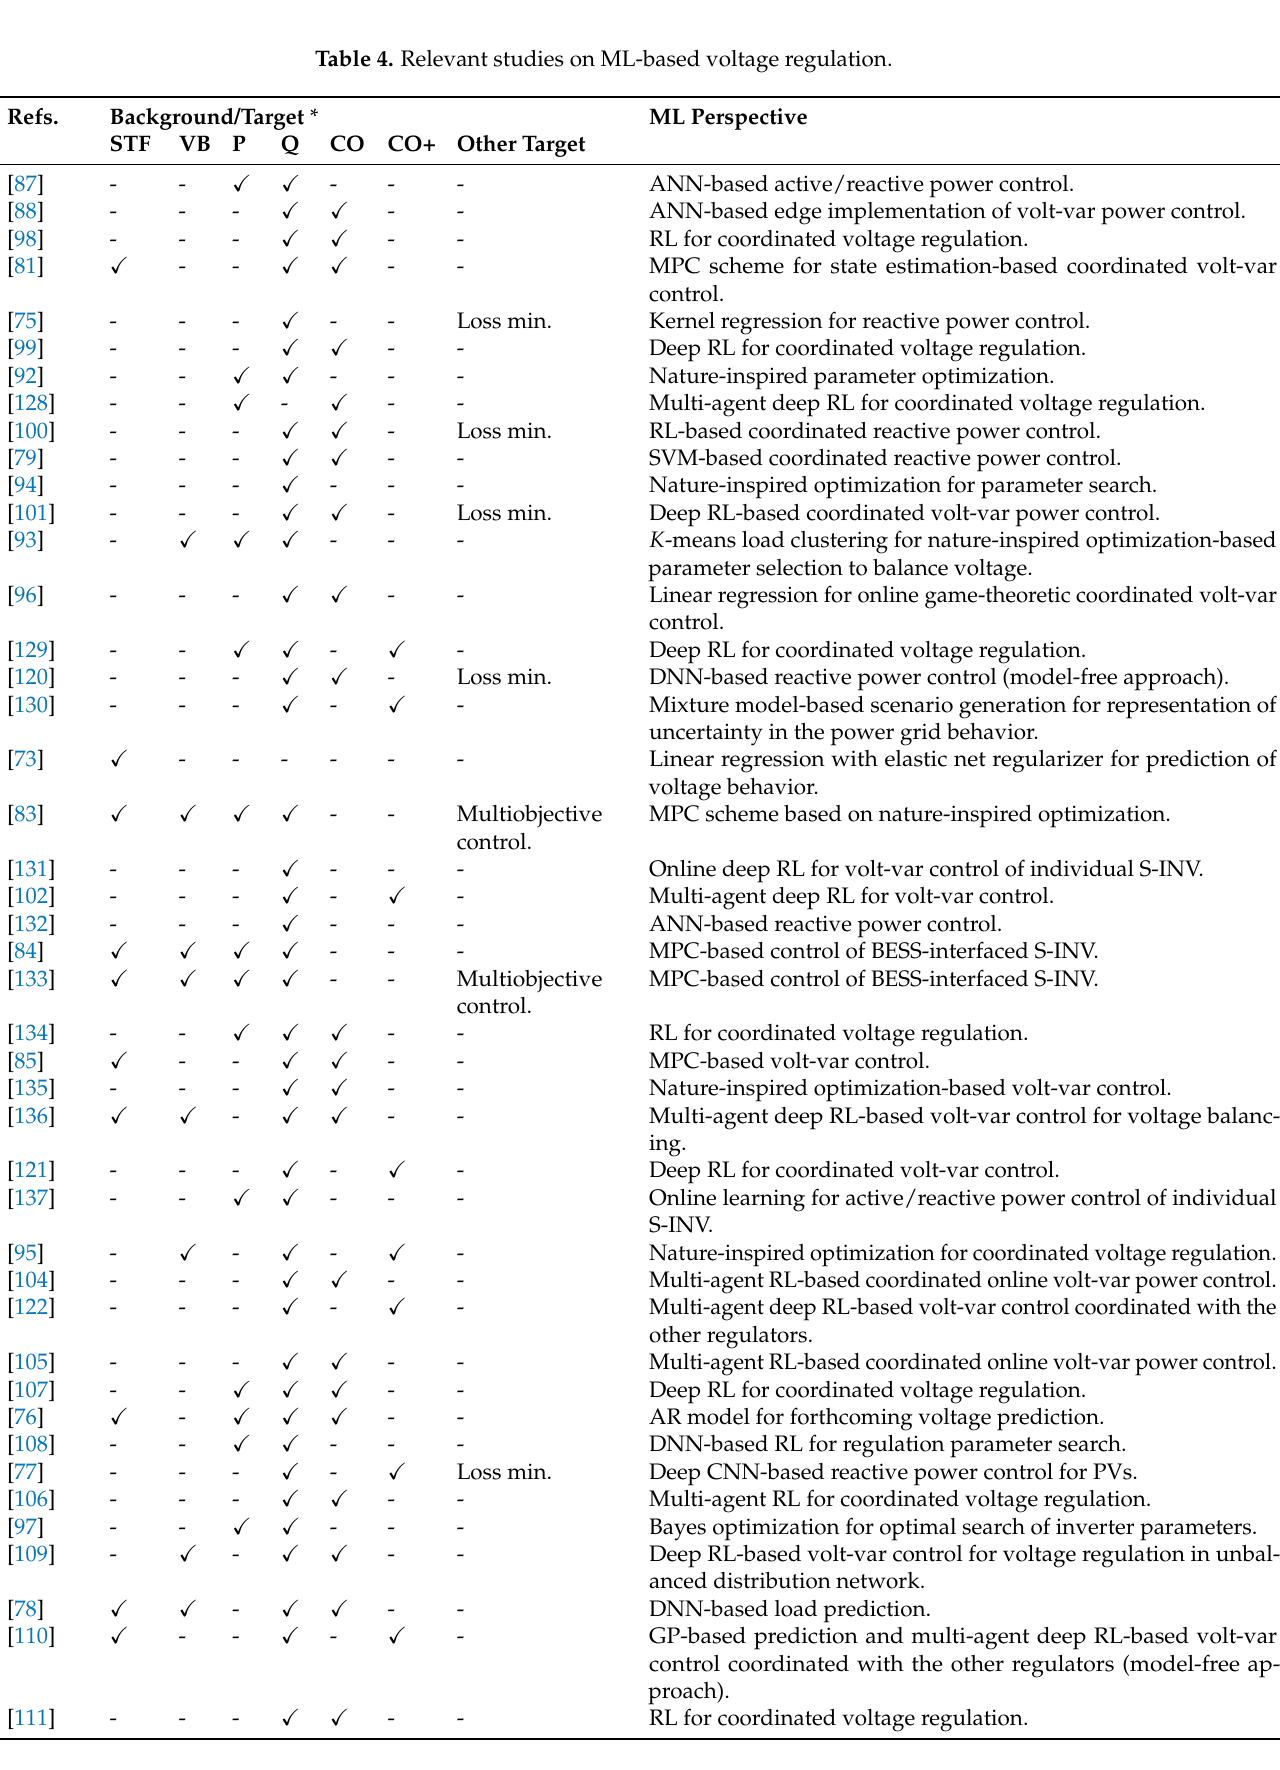
GP-based prediction and multi-agent deep RL-based volt-var control coordinated with the other regulators (model-free ap-